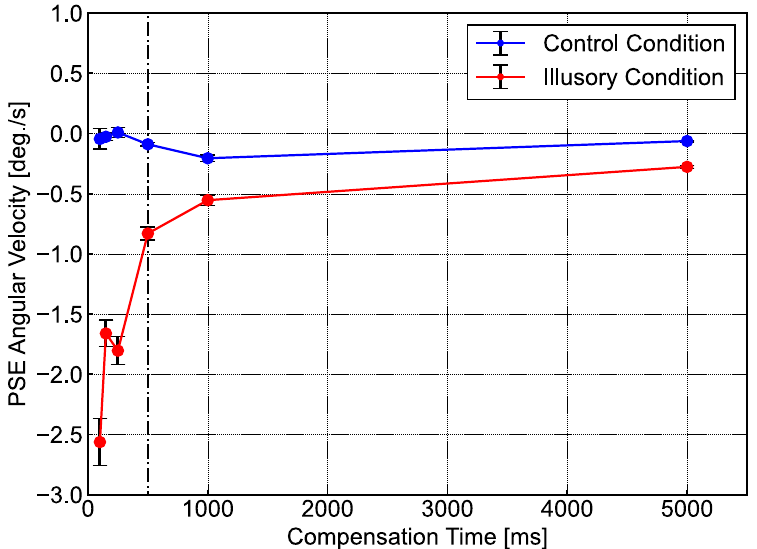
Fig 5. Results of temporal dependence of RSI perception. The horizontal axis presents the compensation time Δ t , and the vertical axis gives the average PSE for the angular velocity obtained by PEST across the subjects. The red and blue lines denote the results for the illusory and control conditions, respectively. The vertical dashed line indicates Δ t = 500 ms, and the error bar presents the standard error. The data for Δ t = 1 are altenatively plotted at Δ t = 5000 ms. The vertical dashed line indicates Δ t = 500 ms. The original data are available in Experiment 2 Table in the (S2 Dataset).